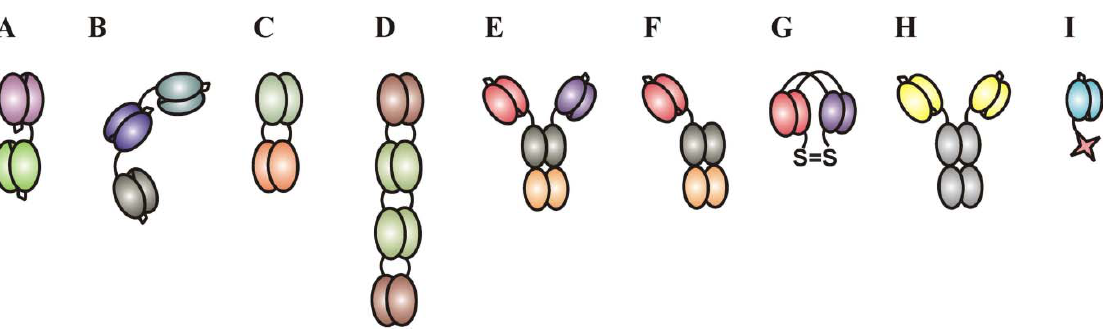
Figure 3. Schematic structure of NK-cell recruiting agents. ( A ) tandem bispecific single chain Fragment variable (bsscFv); ( B ) single chain triplebody (sctb); ( C ) two-chain diabody; ( D ) tandem diabody (TandAb); ( E ) bispecific Tribody (bsTb); ( F ) bispecific Bibody (bsBb); ( G ) dual-affinity re-targeting molecule (DART); ( H ) mini-ab; ( I )